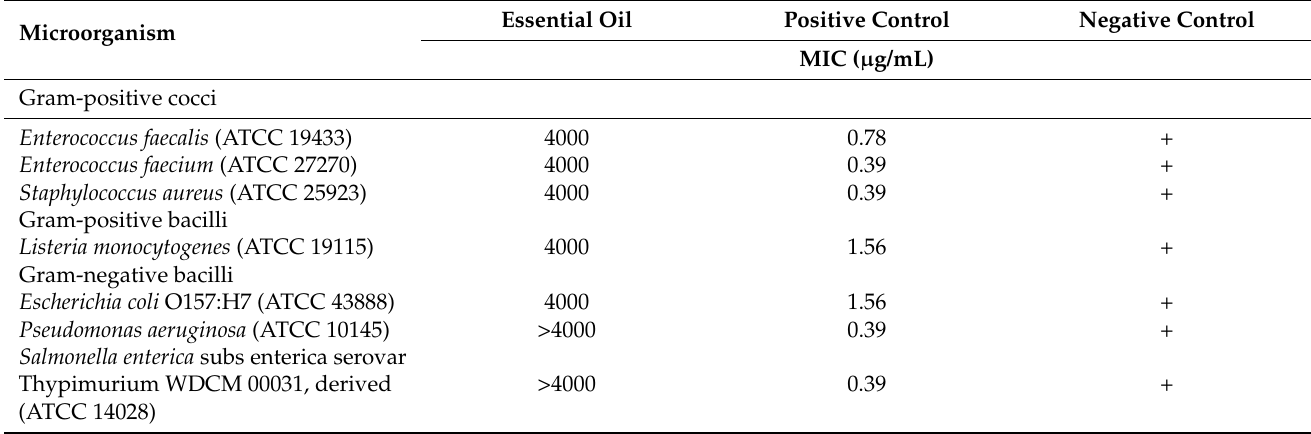
Table 4. Antibacterial activity of essential oil from Peperomia inaequalifolia .